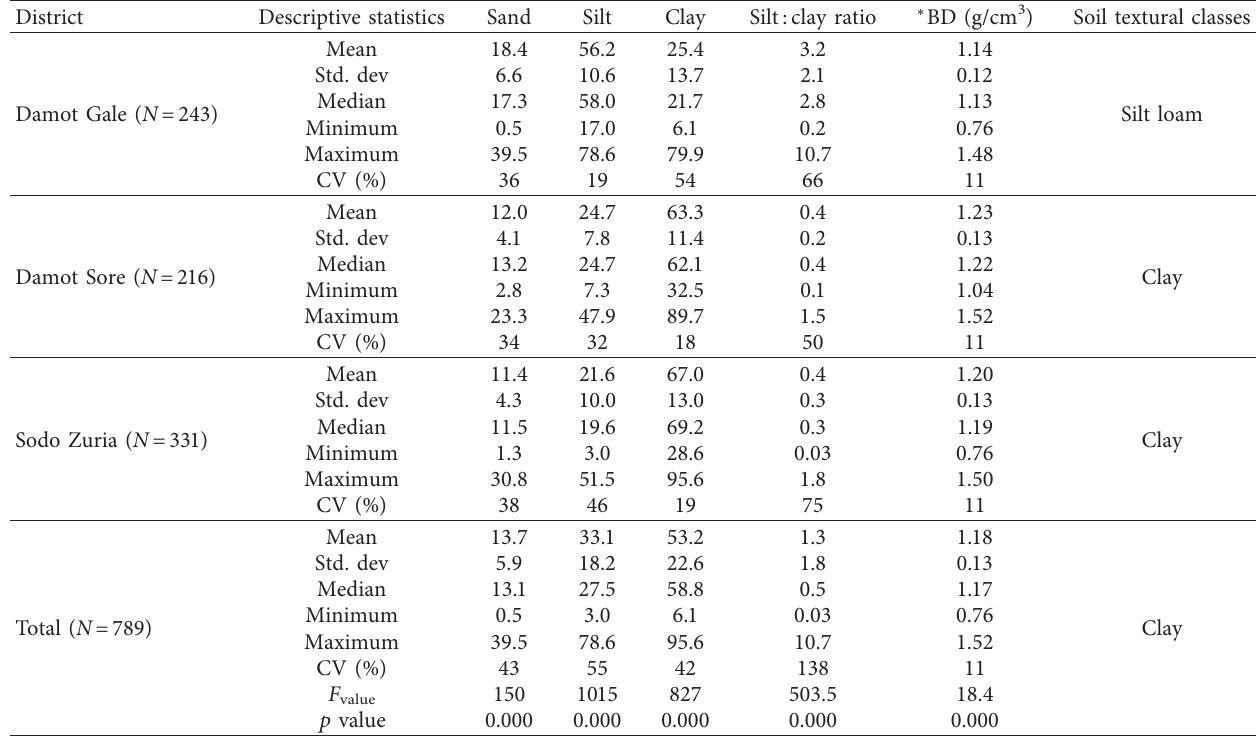
Table 2: Descriptive statistics of particle size distribution, silt: clay ratio, and bulk density for surface soils. District Descriptive